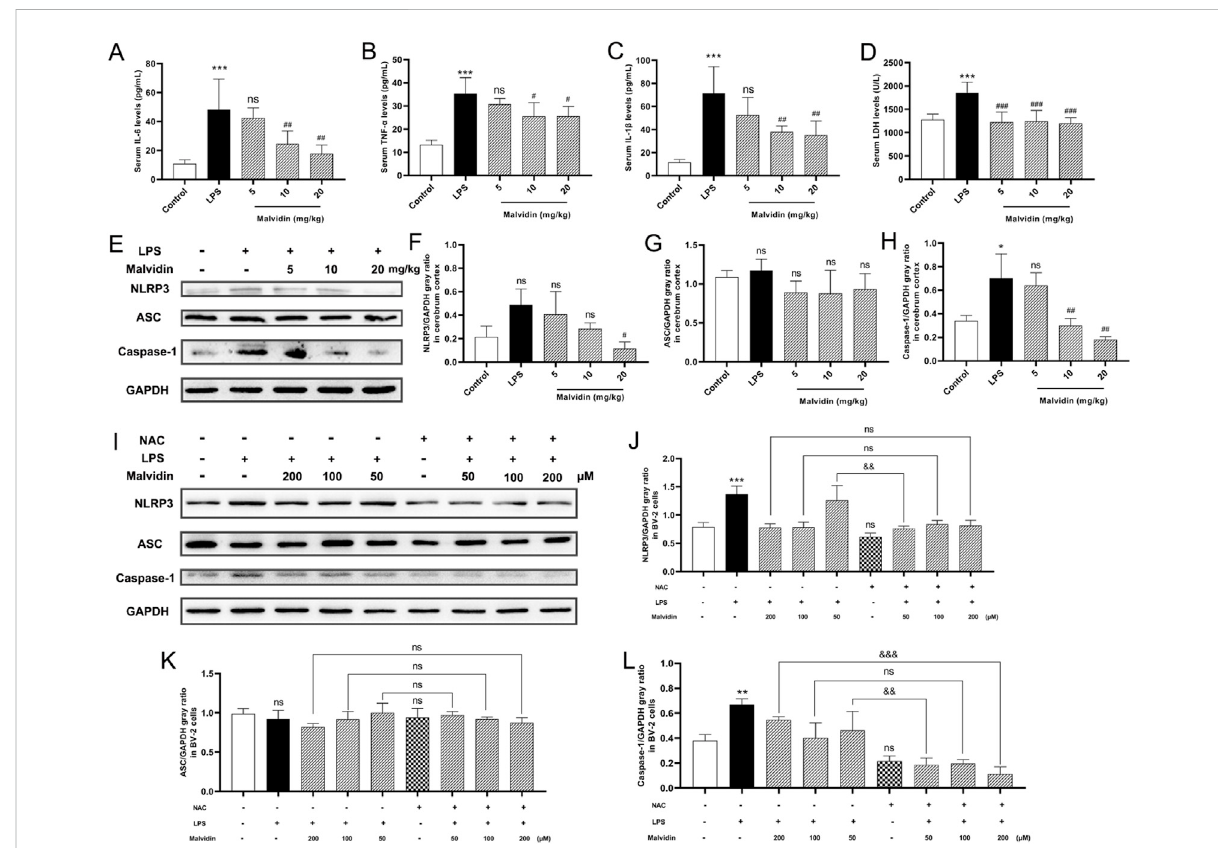
FIGURE 7 MalvidinprotectsagainstLPSinducedSAEmicecerebrumin fl ammationthroughinhibitingROS-mediatedNLRP3in fl ammasomeactivation. (A) Pro-in fl ammatory cytokines IL-6 (A) , TNF- α (B) , IL-1 β (C) secretion and LDH (D) release levels in the SAE mice serum. (E) The expression levels of NLRP3 in fl ammasome releated proteins ofNLRP3, ASC and caspase-1 in thecerebrum tissues using immunoblotting assays. GAPDH was used as an internal reference. Gray ratio analysis of NLRP3/GAPDH (F) , ASC/GAPDH (G) and caspase-1/GAPDH (H) in (E) using ImageJ and excel software ( n = 3). (I) The expression levels of NLRP3 in fl ammasome releated proteins of NLRP3, ASC and caspase-1 in BV-2 cells lysates using immunoblotting assays. GAPDH was used as an internal reference. Gray ratio analysis of NLRP3/GAPDH (J) , ASC/GAPDH (K) , and caspase-1/GAPDH (L) in (I) using ImageJ and excel software ( n = 3). Statistical analysis was conducted using one-way ANOVA followed by Tukey ’ s post hoc testing. * represents comparisonbetweenLPSgroupandcontrolgroup, #representscomparisonamongmalvidingroupsandLPSgroupin (A – D,F – H) orbetween NAC group and control group in (J – L) , whereas & indicates analysis among LPS injection combined with malvidin pretreatment groups with or without NAC pretreatment groups in (J – L) . */# is p < 0.05, **/##/&& is p < 0.01, ***/###/&&& is p < 0.001, and ns is p >